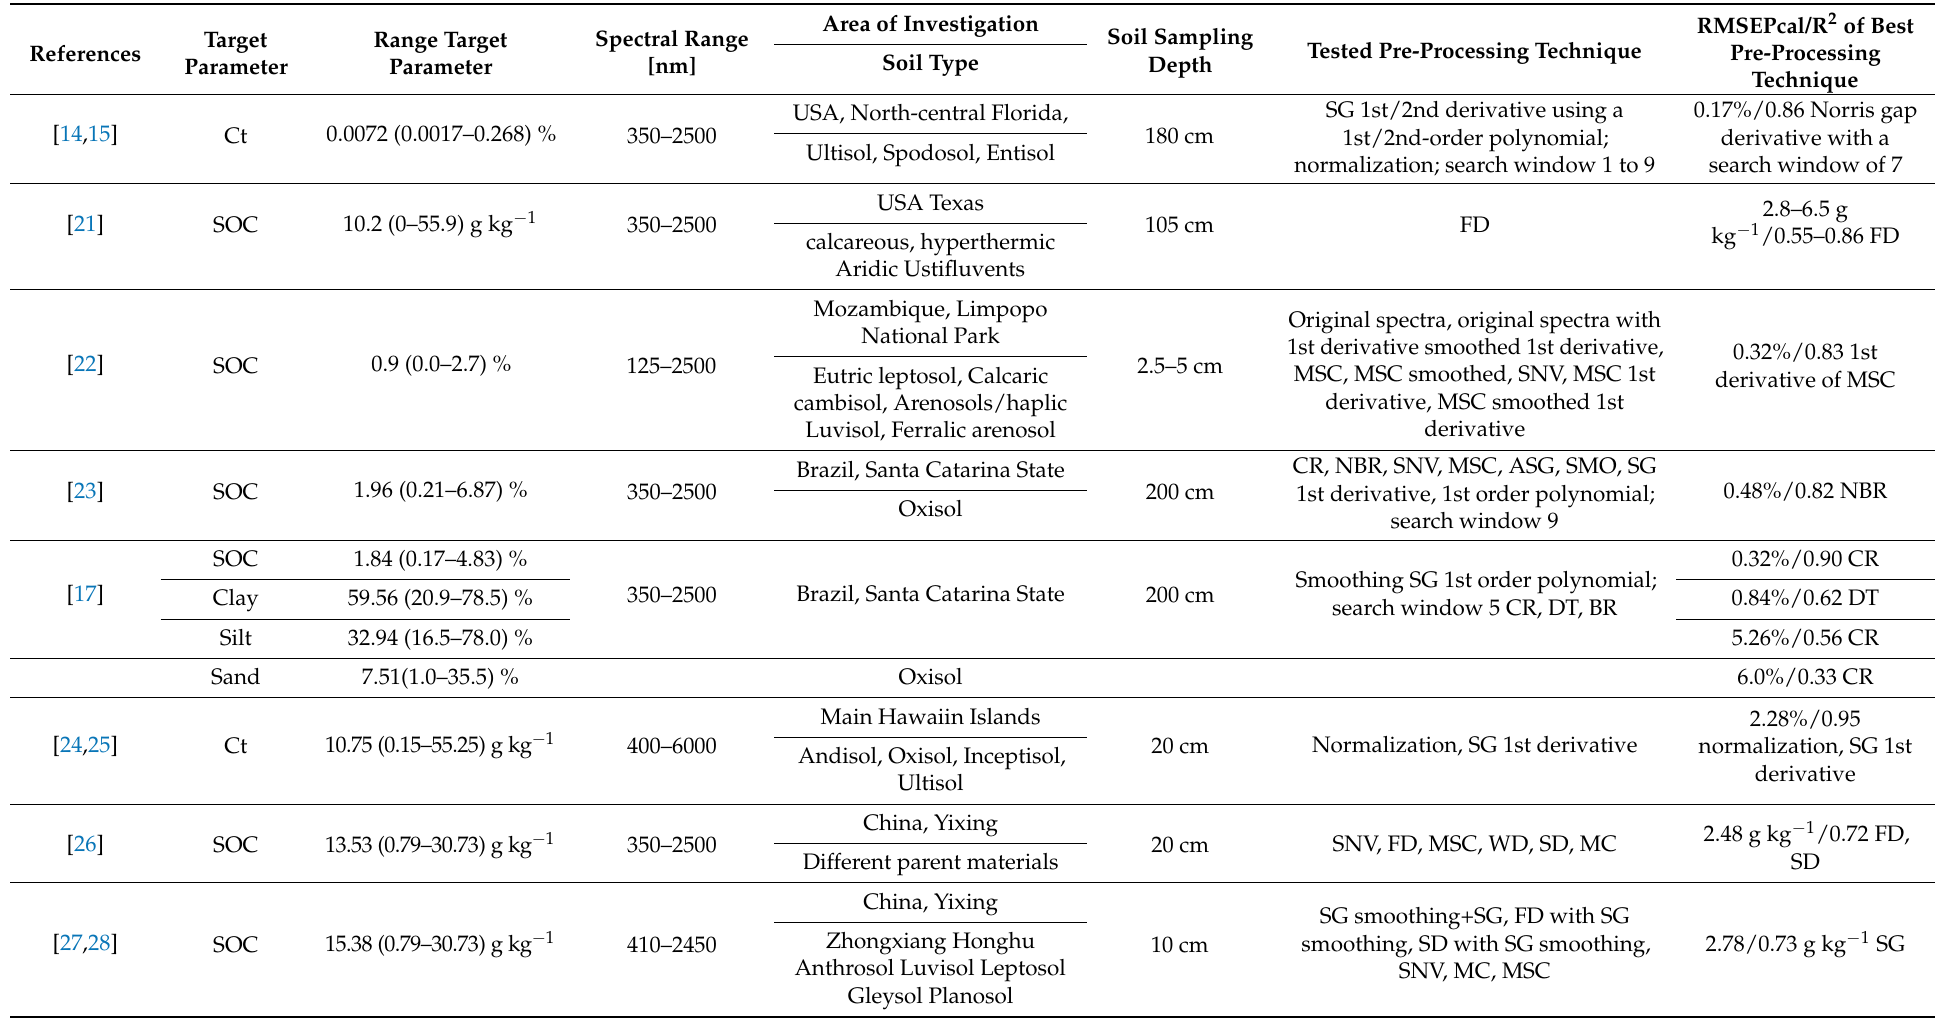
Table 1. Overview of applied evaluations with near-infrared reflectance (NIR) spectroscopy, mainly during the last decade, including their target parameters, spectral ranges, pre-processing techniques, and